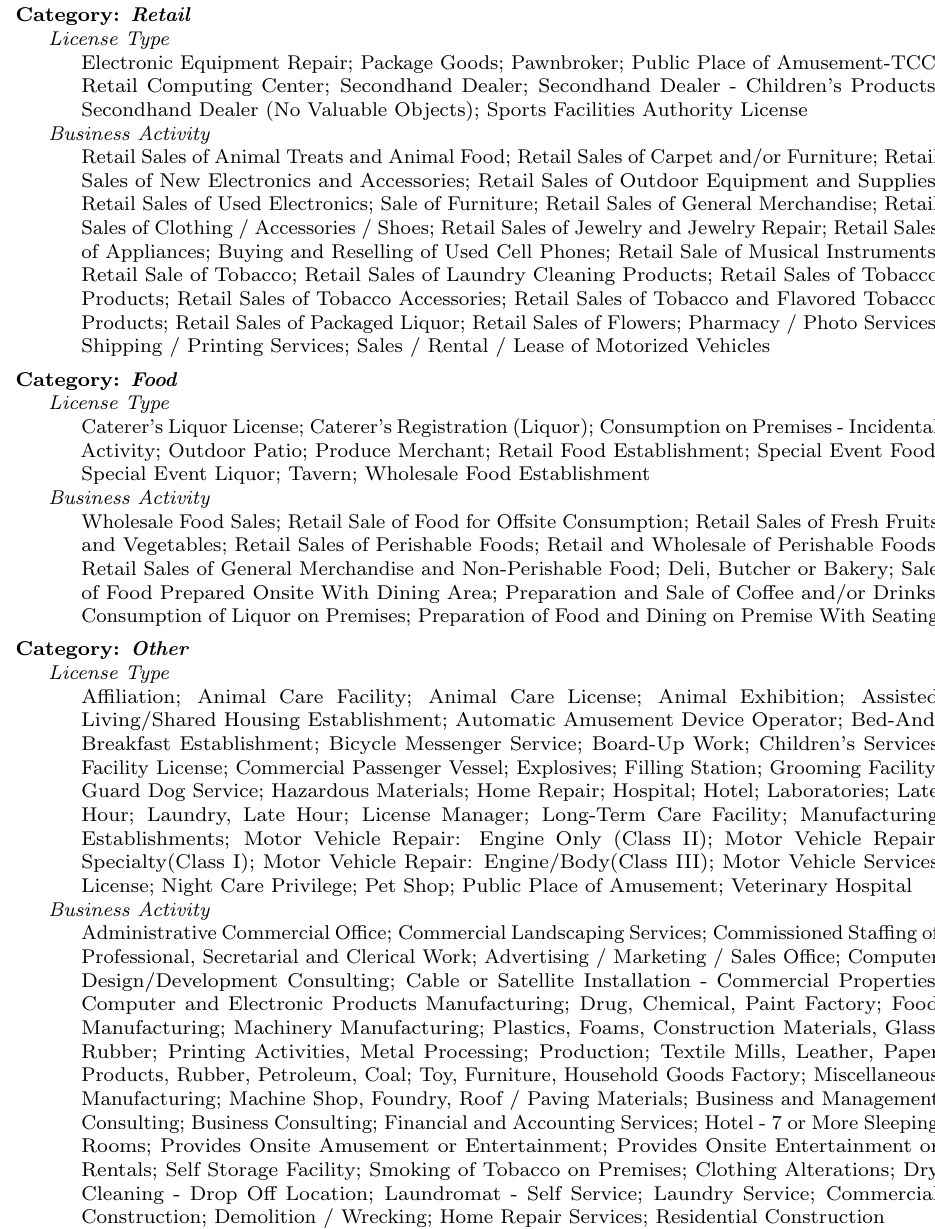
Table 1: Sample of classification scheme for assigning license types and business